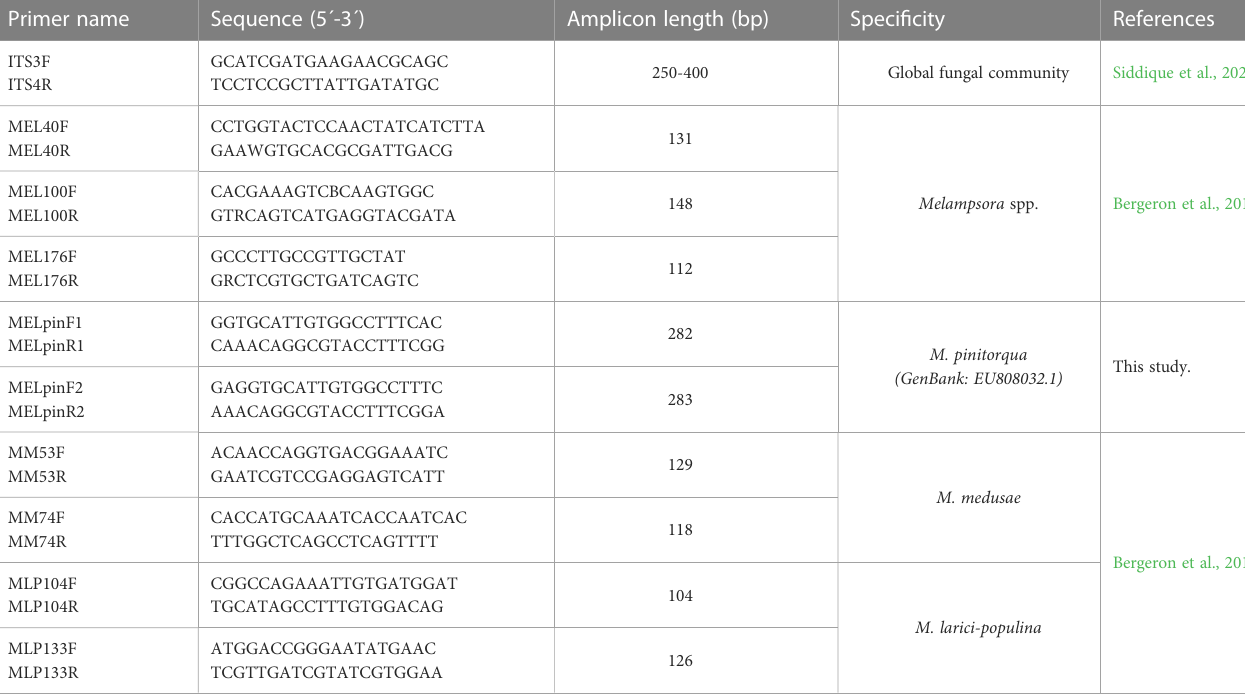
TABLE 1 Primers used in this work to amplify the ITS2 region (representing the global fungal community), pathogenic rusts belonging to the genus Melampsora ( M. spp.), and individual native (M. pinitorqua) and non-native (M. medusae and M. larici-populina) rust species in leaves of aspen ( Populus tremula